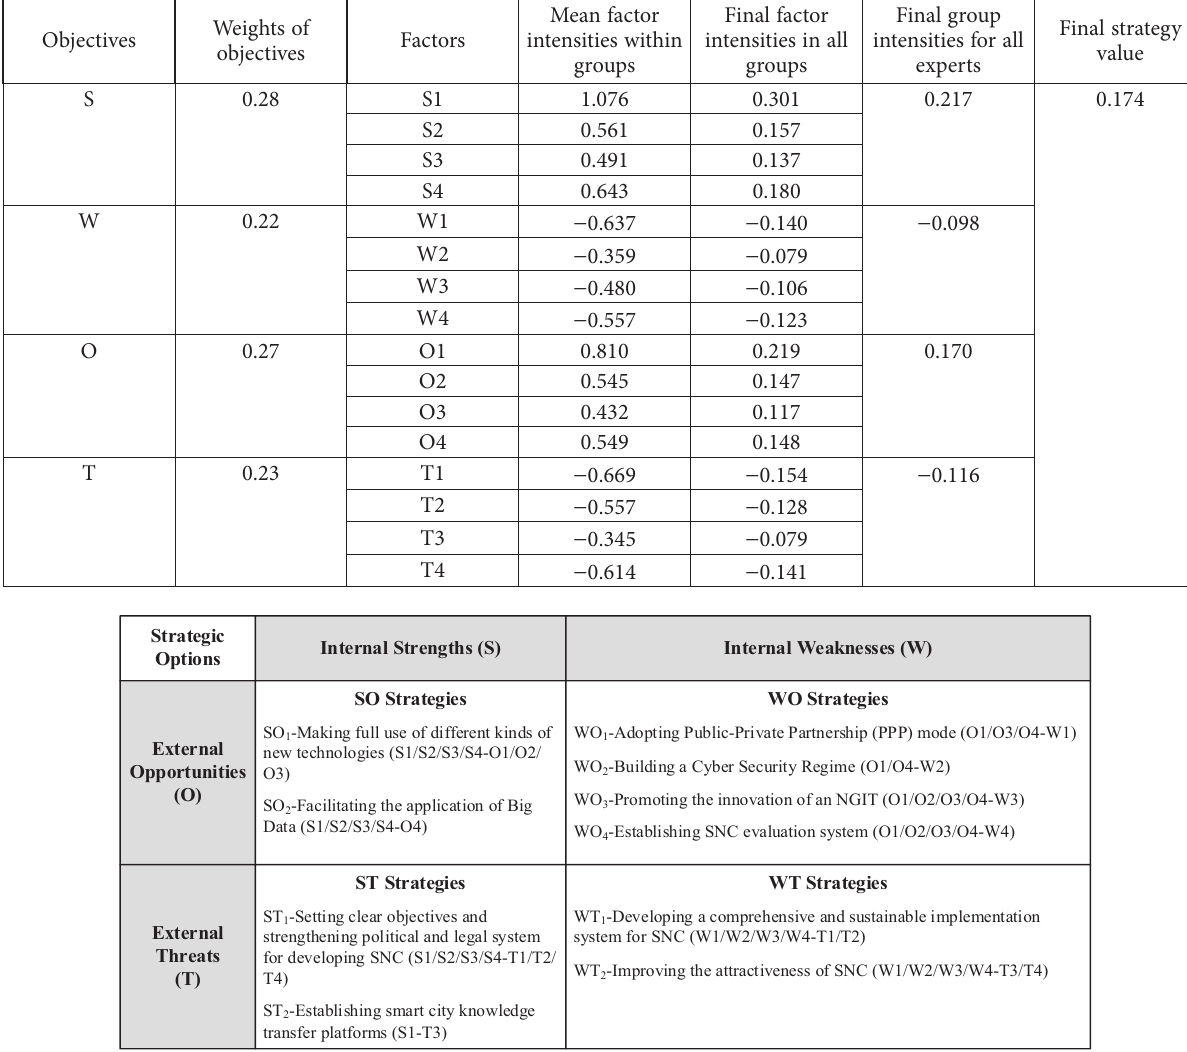
Table 4. Final group intensities and strategy values in SNC (all experts)